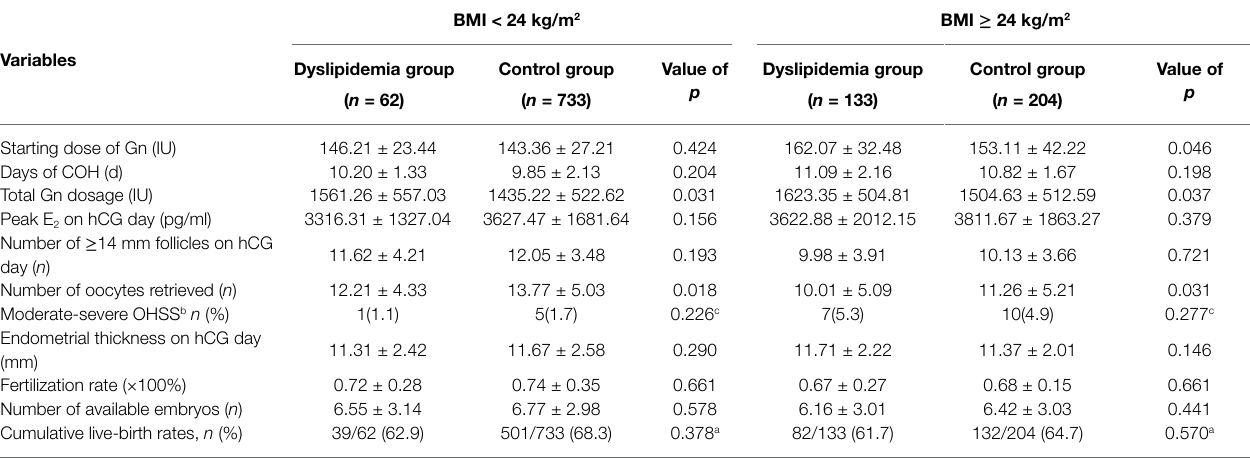
TABLE 3 | Subgroup analysis of main parameters in different BMI groups with and without dyslipidemia.